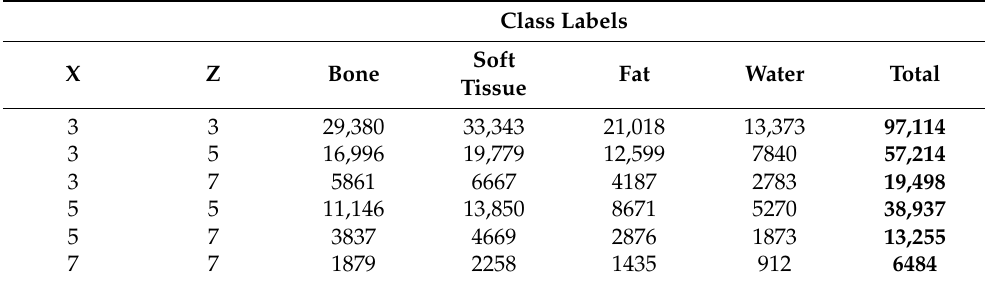
Table 1. Composition of the labeled dataset used for training and individual model testing. Entries in each cell represent numbers of non-overlapping X by X by Z by 2 tensors in the labeled dataset.